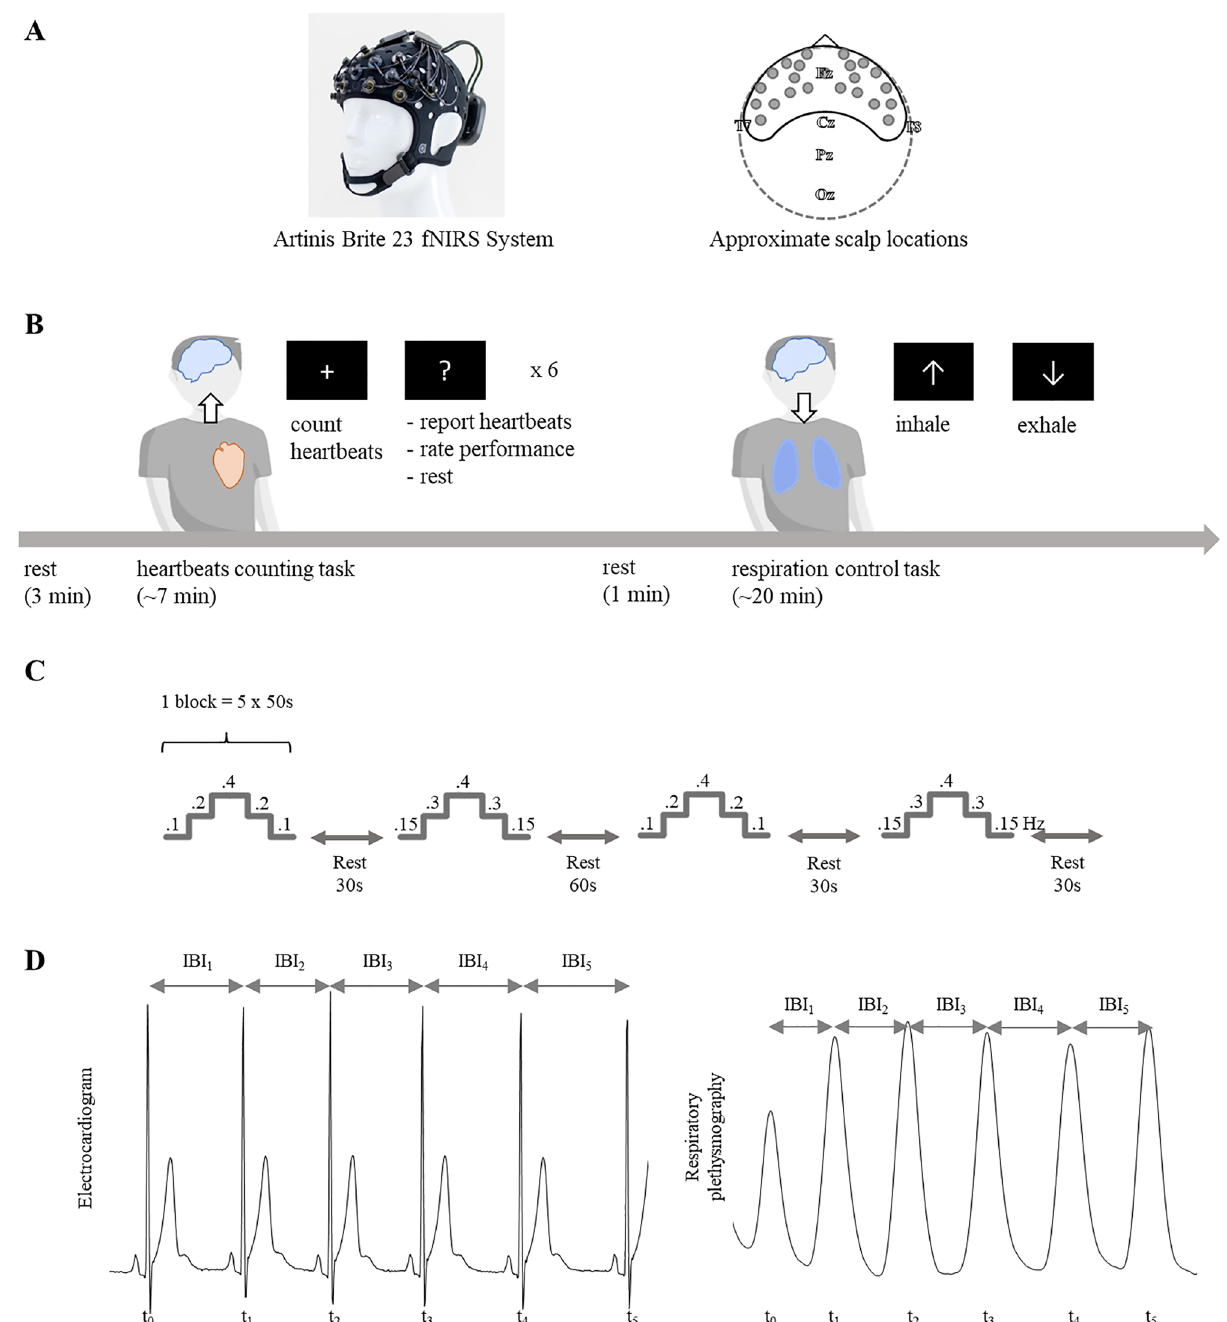
Figure 1. ( A ) Brite 23 (Artinis Medical Systems B.V., the Netherlands), the fNIRS system used in the experimental protocol. ( B ) Experimental protocol: heartbeat counting task and breathing control task. ( C ) Detailed transition during the breathing control task. ( D ) Estimation of heart and breathing